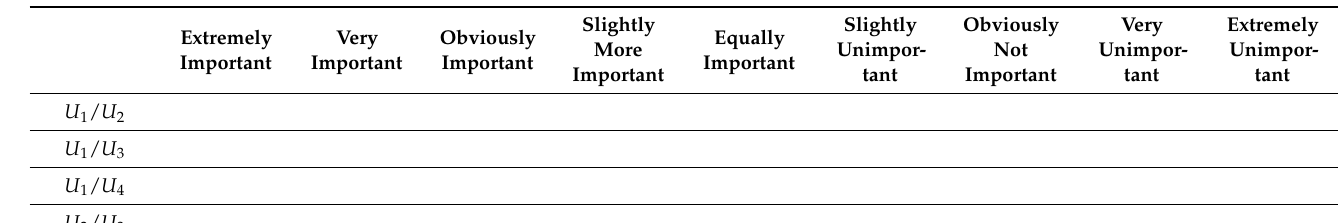
At the level of political responsibility ( U ) for large municipal road projects (1), please compare the relative importance of the following secondary indicators two by two.